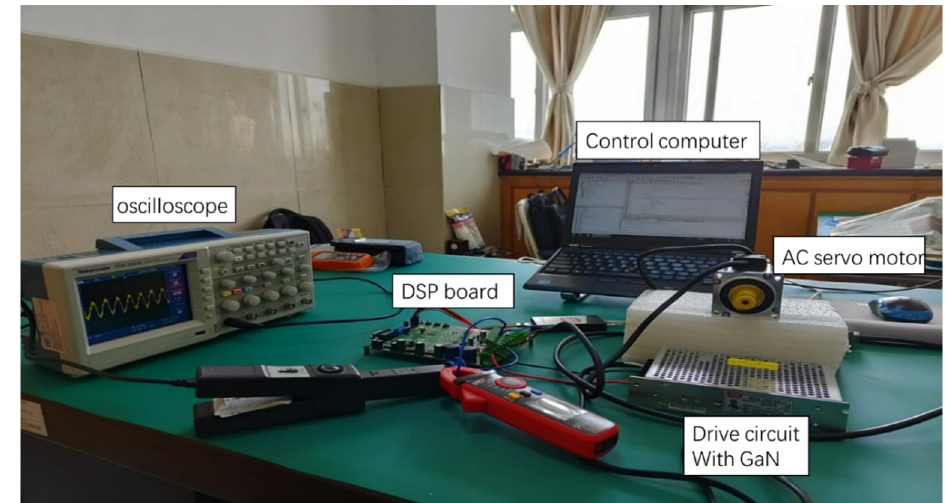
Figure 9. Configuration of experimental setup. Figure 8. Block diagram of the overall hardware control system.